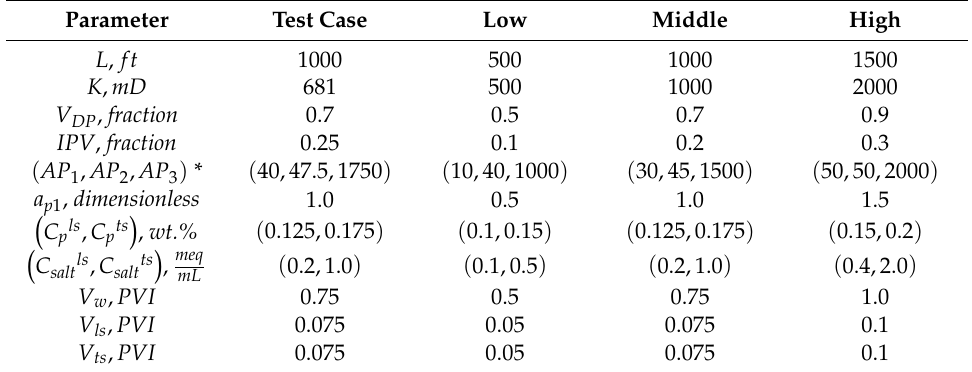
Table 1. List of parameters and corresponding ranges used in the design-of-experiments (DoE)